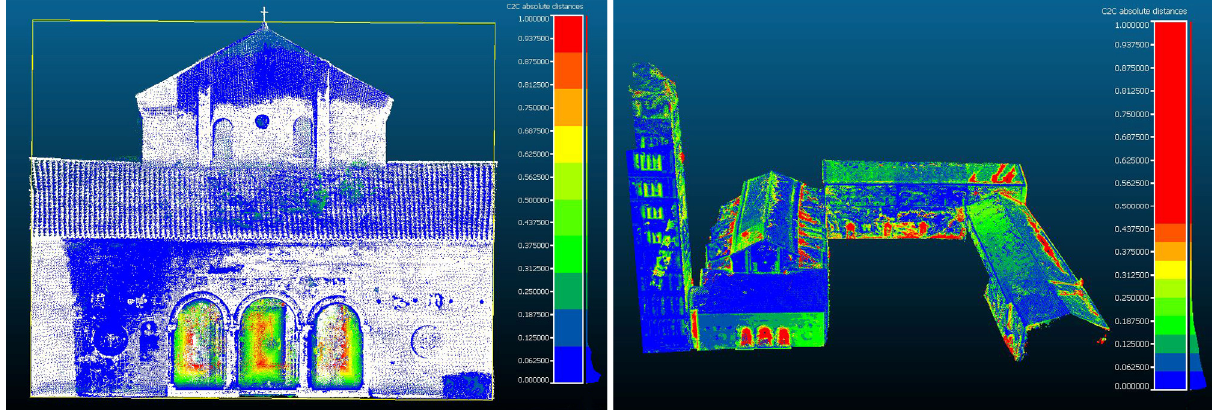
Figure 10. Examples of graphic visualization of deviations between 3D laser scanner points cloud (gold standard) and 2D